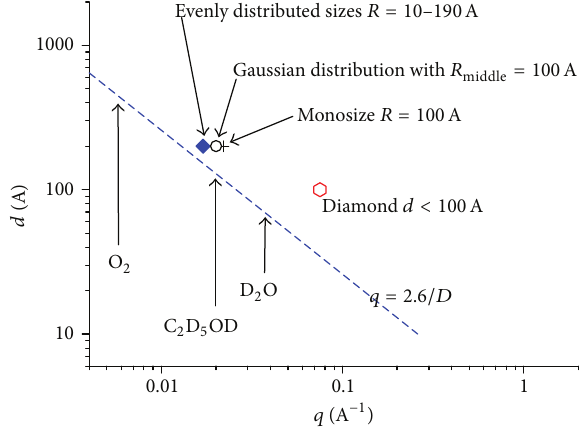
Figure 3: Estimation of sizes of nanoparticles in impurity-helium